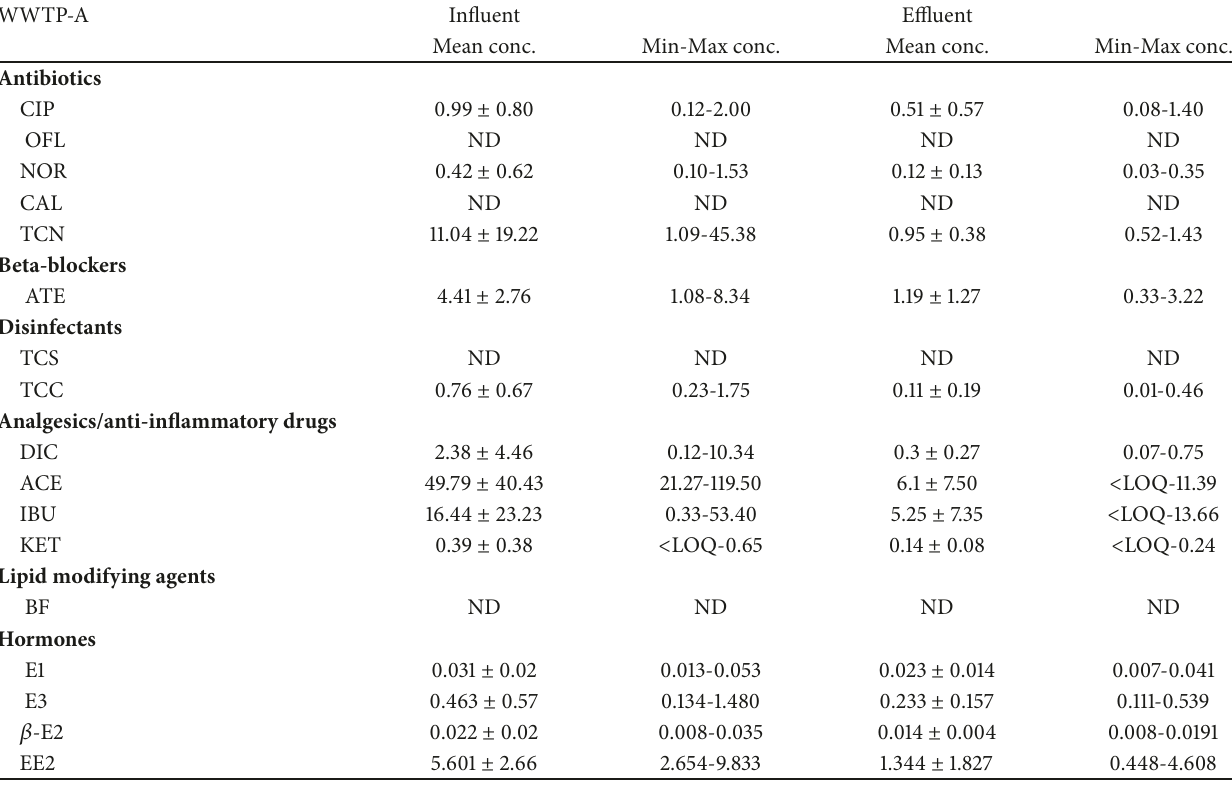
Table 6: Overall concentrations of pharmaceuticals in influents and effluents ( 𝜇 g/L) in WWTP-A.